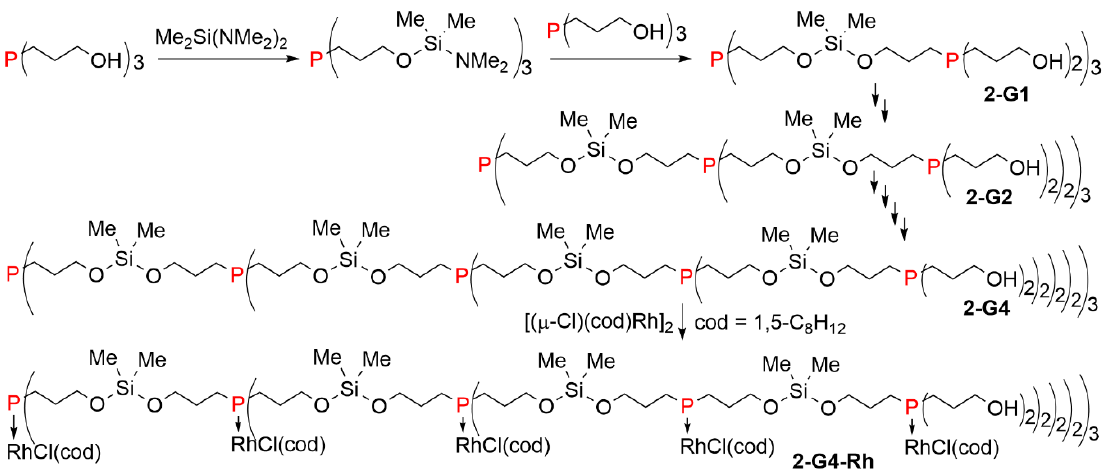
Figure 2. Full chemical structure of the dendritic complex 2-G4-Rh , synthesized as shown in Scheme 2.